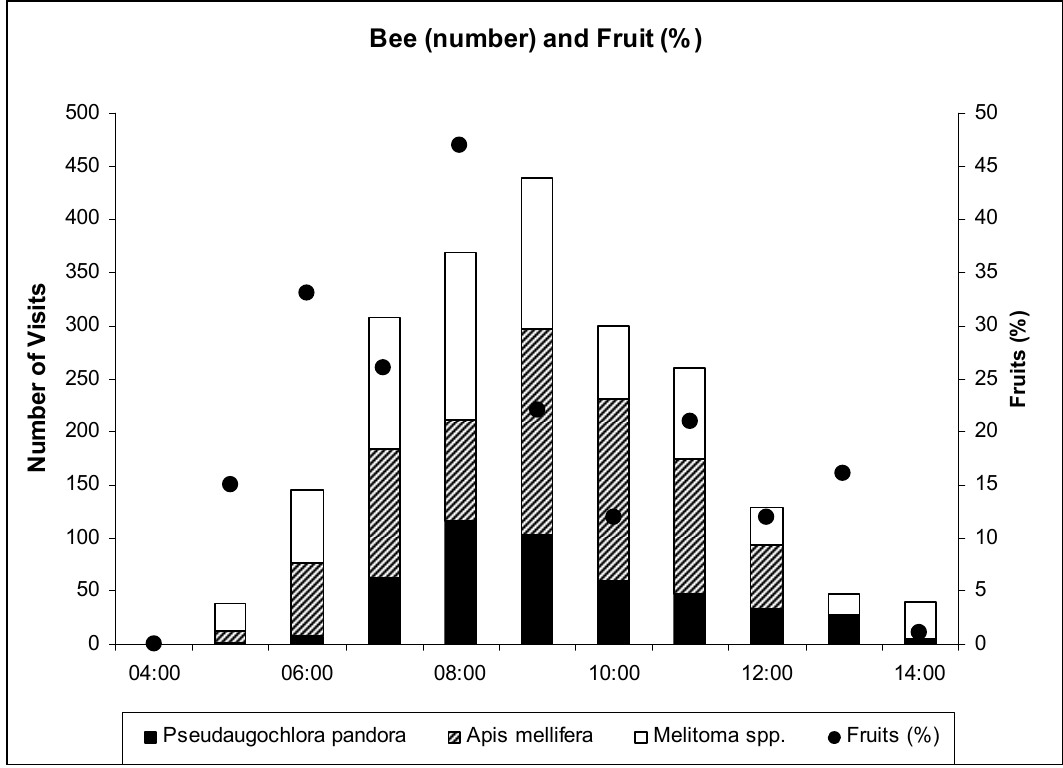
Fig 3. Number of visits of the most frequent bees ( Melitoma spp, Apis mellifera, and Pseudaugochlora Pandora ) on flowers of Ipomoea bahiensis (Convolvulaceae), per hour interval throughout the day, on the Campus of Universidade Estadual de Feira de Santana, BA, Brazil between July and October